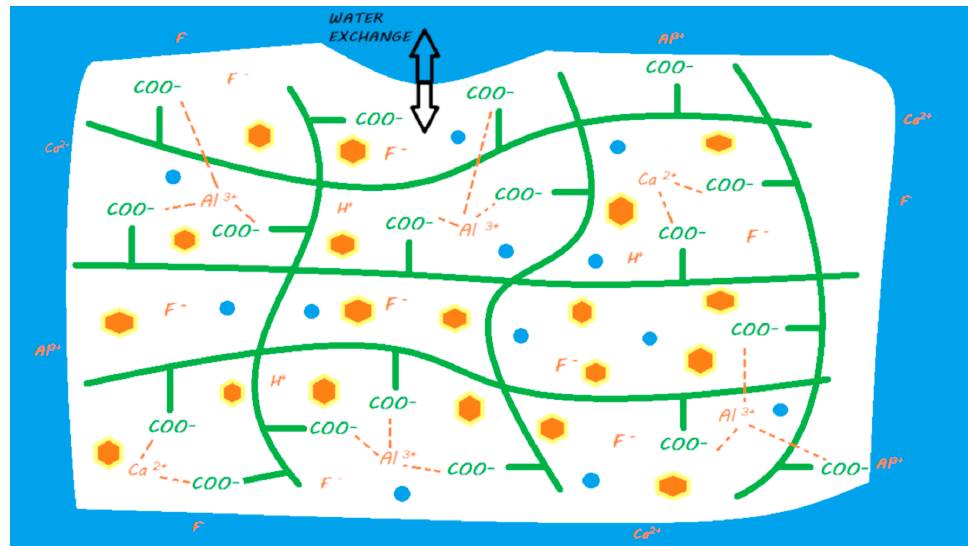
Figure 3. Ion release processes from a conventional GIC once it is in a moist environment (i.e., an oral environment). When the powder and liquid are mixed, the acid–base reaction is initiated, the setting of the material begins, and the FAS fillers are partially attacked. A silicic gel is partially formed on the FAS filler surface. The released calcium and aluminum ions are able to form ionic bonds with the ionized carboxylic groups. Fluoride ions are also released. In water, calcium, aluminum, and fluoride ions (and eventually other ions) are able to be exchanged with the oral